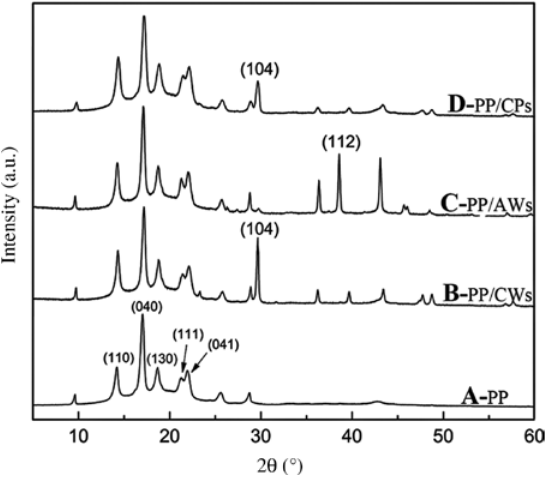
Figure 6: X-ray diffractions of neat PP and composites reinforced with 5% CWs, AWs, CPs.